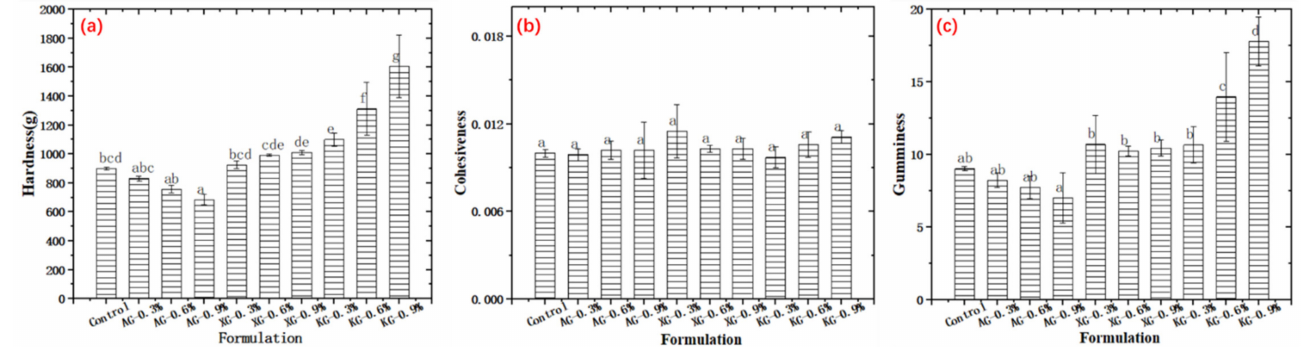
Figure 7. Texture properties of 3D printed samples. ( a ): hardness; ( b ): cohesiveness; ( c ):